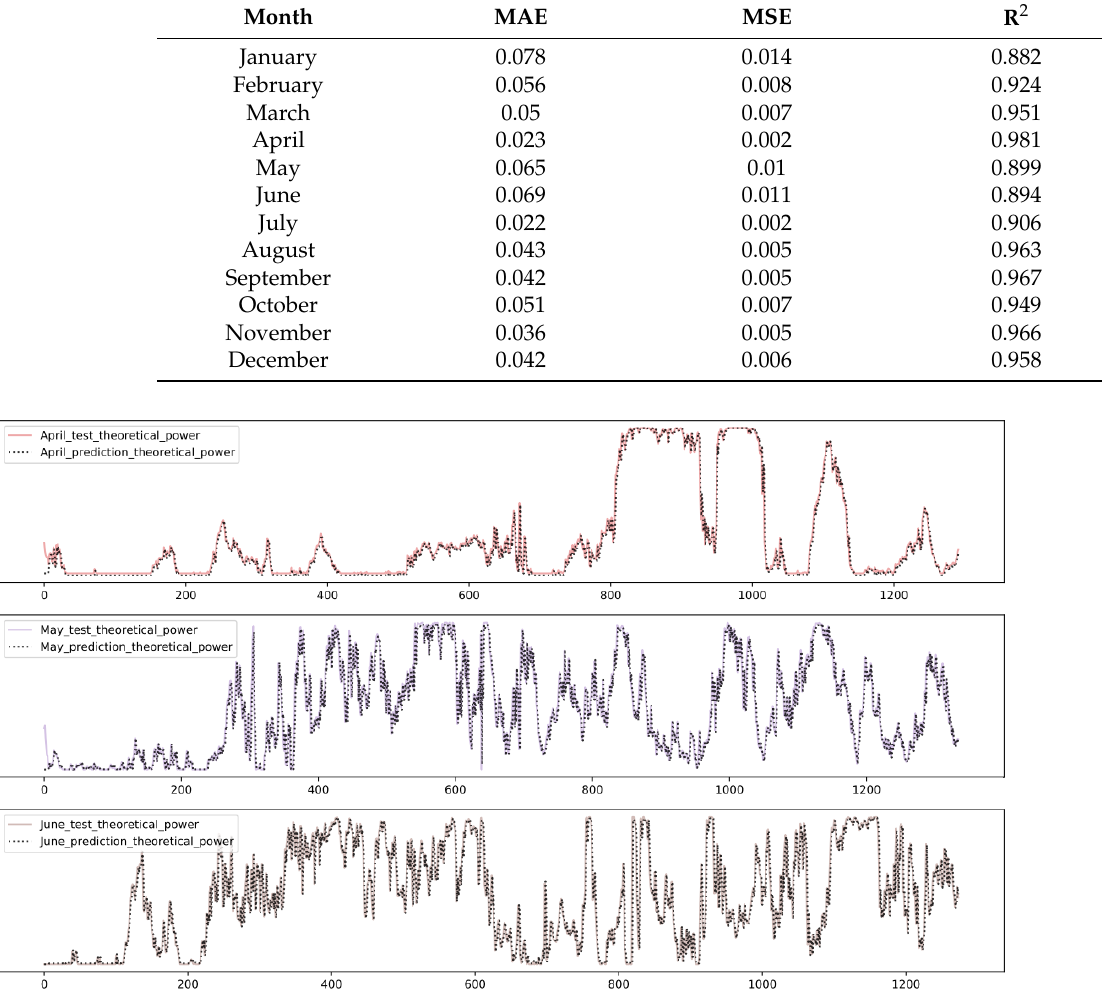
Figure 20. The theoretical power predictions for the test set of April, May, and